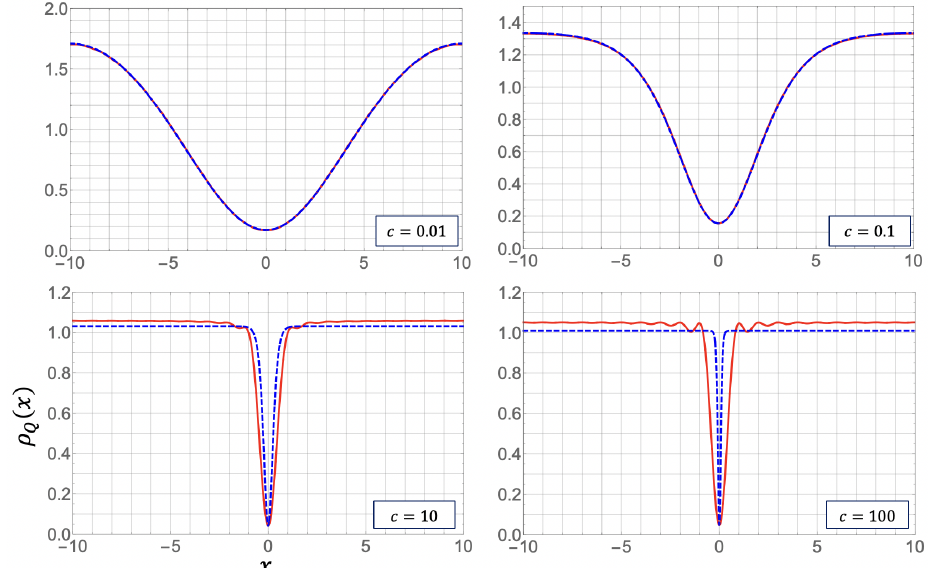
Figure 6. Density profiles for N = L = 20, and c = 0.01, 0.1, 10, and 100 (red solid curves), and the corresponding elliptic solutions (blue dashed curves). The corresponding quantum state is given by Equation (31), which has J = 1. In the panels of c = 0.01 and 0.1, the red solid curves completely agree with the blue dashed curves,